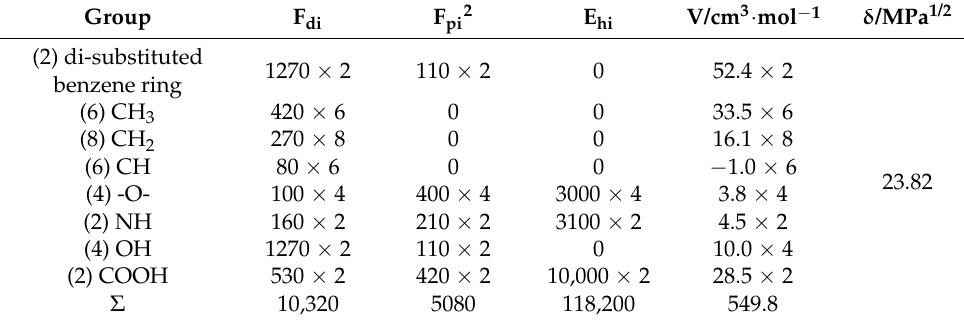
Table 2. Calculation of solubility parameter for MPT.